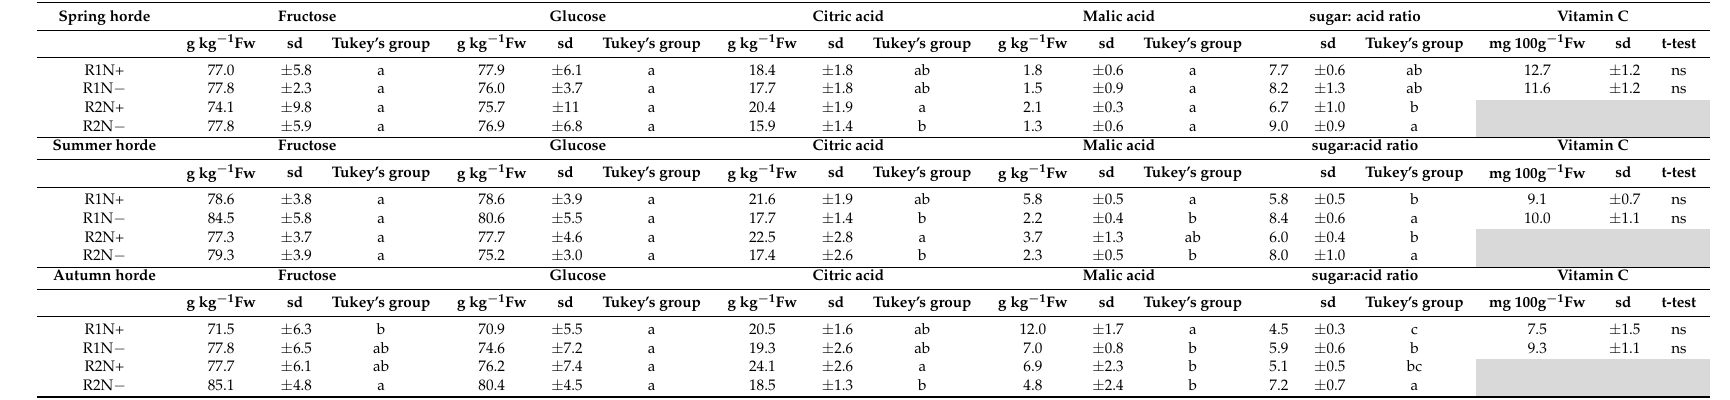
Table 3. Fructose, glucose, citric acid and malic acid contents, sugar:acid ratio and vitamin C content in the pericarp of red (55DAA) tomato fruits of R1 and R2 according to nitrogen supply N+ and N − . Spring, summer and autumn hordes are presented. Values are expressed in g kg − 1 of fresh weight, with the exception of vitamin C content which is expressed in mg 100g − 1 of fresh weight. sugar:acid ratio was calculated and has no unit. Average data are from 5 samples per treatment and per horde. sd stands for standard deviation. Hordes are analyzed separately. Letters indicate results of statistical analysis according to Tukey’s test: different letters indicate statistical differences between replicates and nitrogen treatments. T-test analysis was performed for vitamin